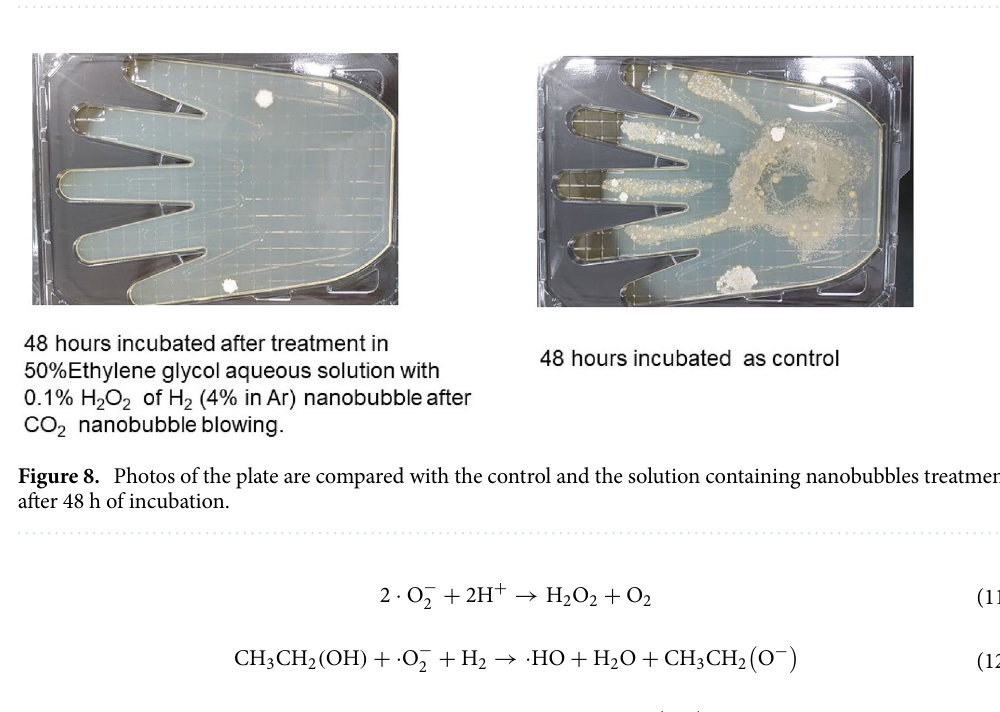
Figure 7. Peaks of hydroxyl radical with ESR by blowing CO 2 after H 2 (4% in Ar) gas nanobubble and H 2 (4% in Ar) after CO